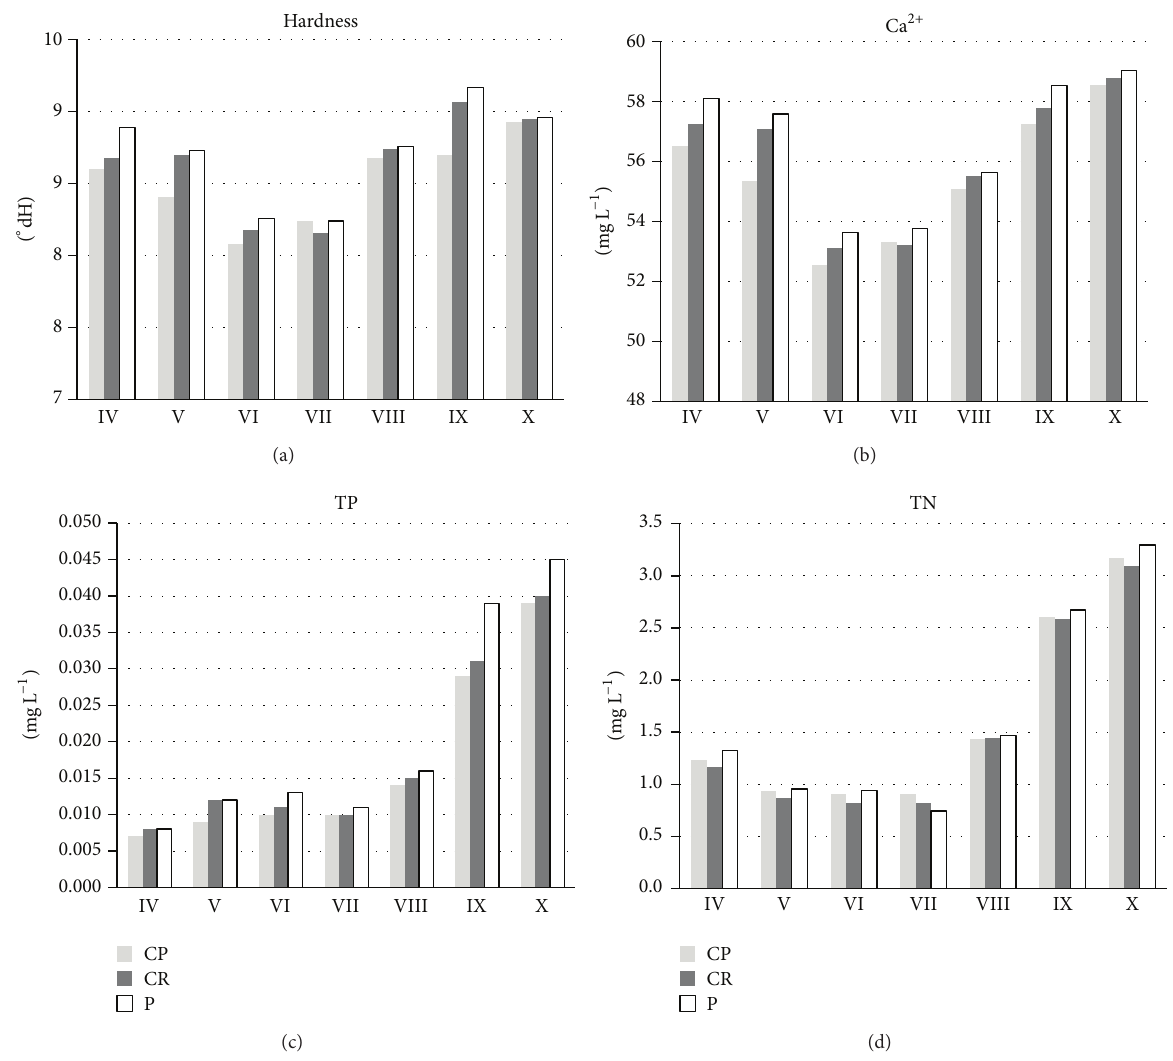
Figure 2: Month-to-month temporal variability of total hardness (a), Ca 2+ concentration (b), TP: total phosphorus (c), and TN: total nitrogen (d) in water from study sites: C. polyacantha site (CP), C. rudis site (CR), and pelagial (P). The roman numbers mean the months of